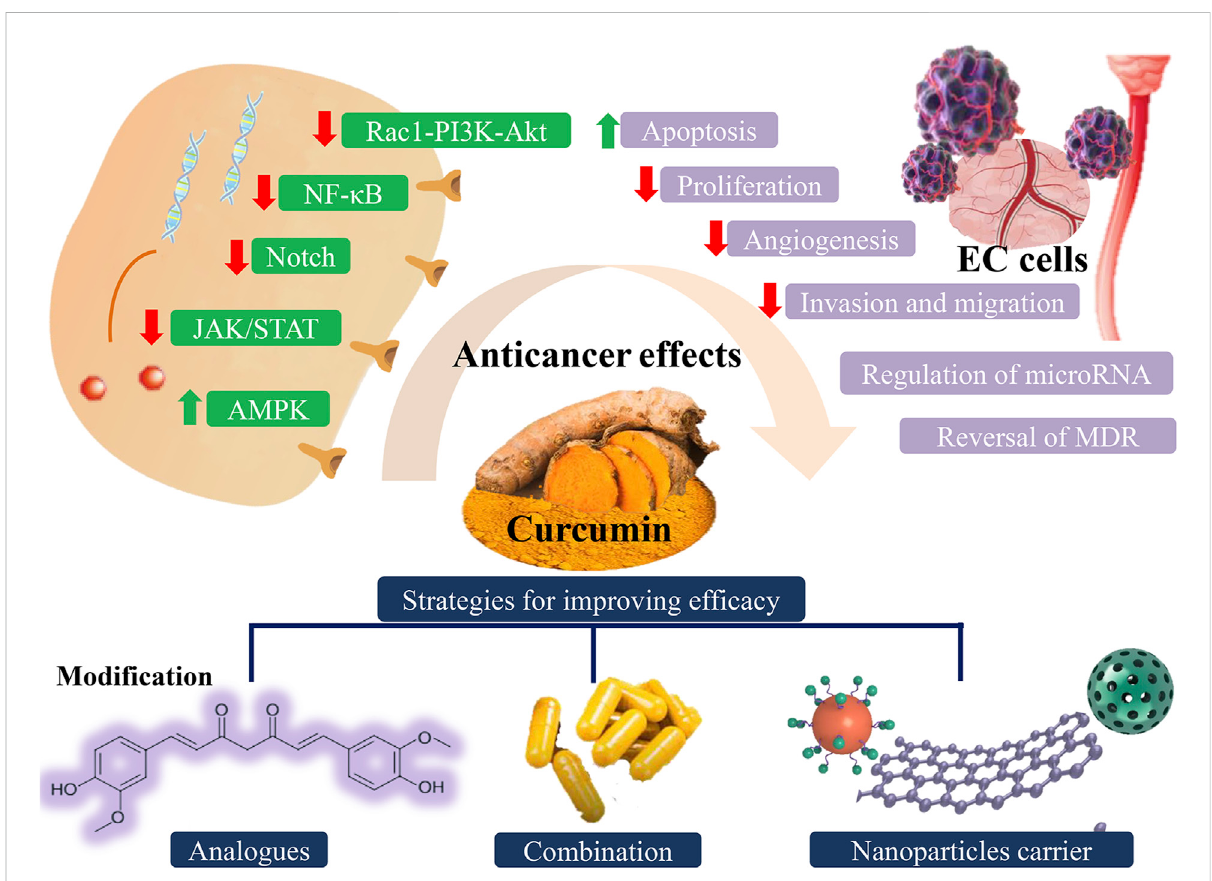
FIGURE 1 Different anticancer effectsof curcumin involvedinmultiplesignalingpathwaysand possiblestrategies for improvingef fi cacy ofcurcumin.EC: esophageal